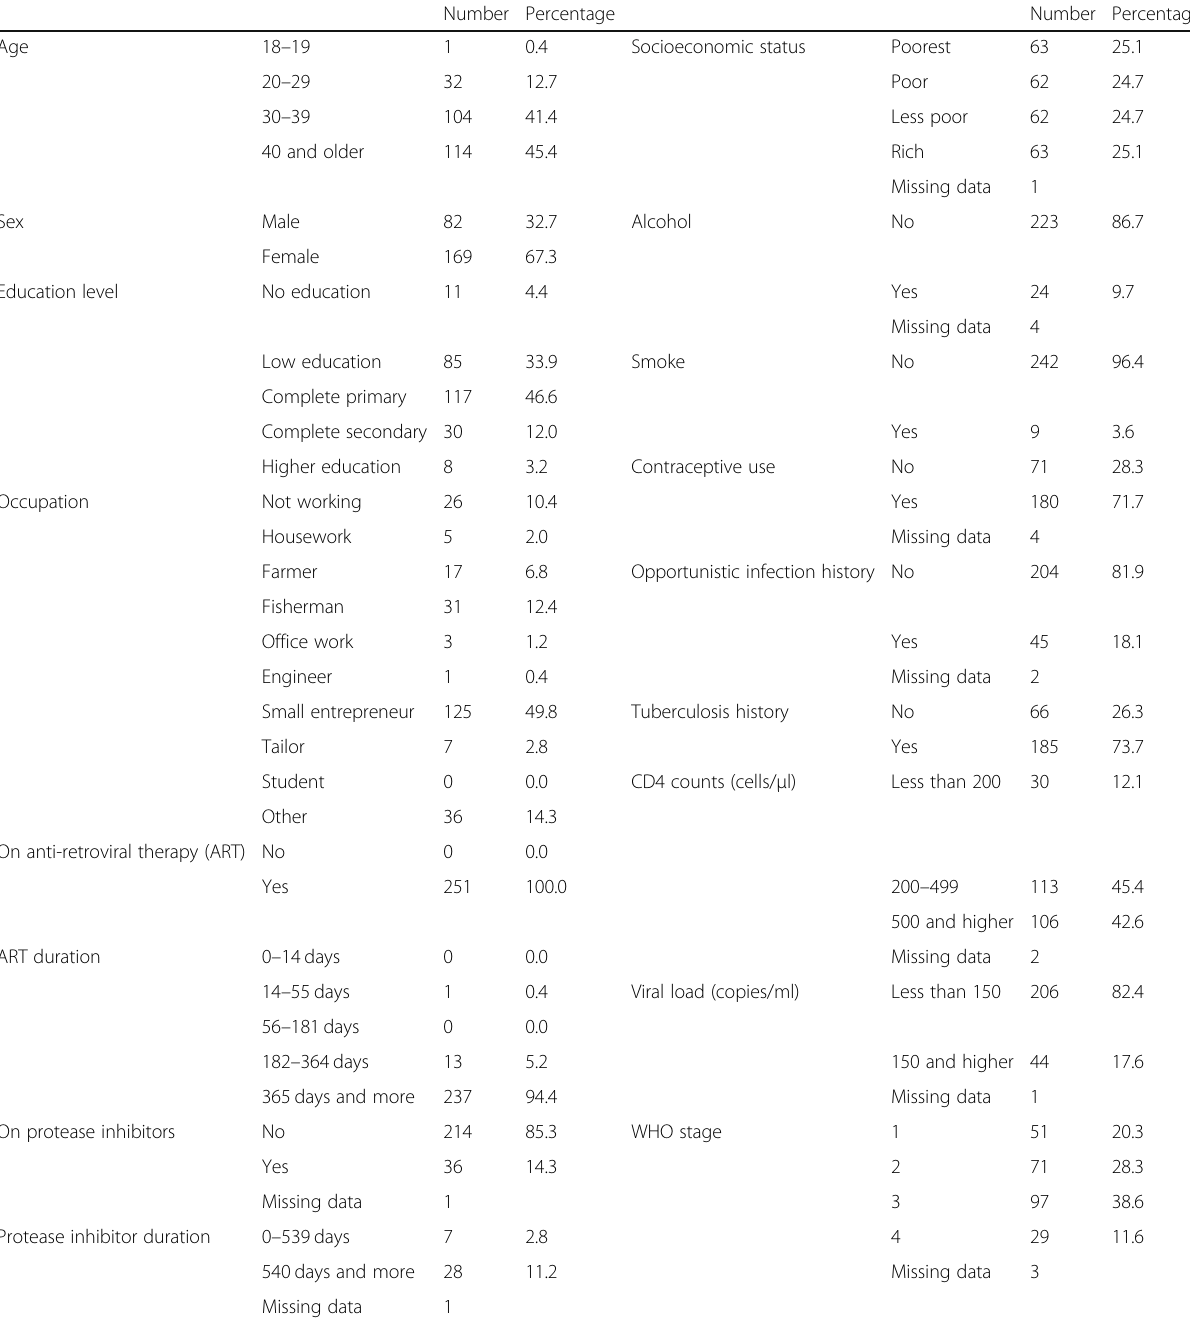
Table 1 Participant